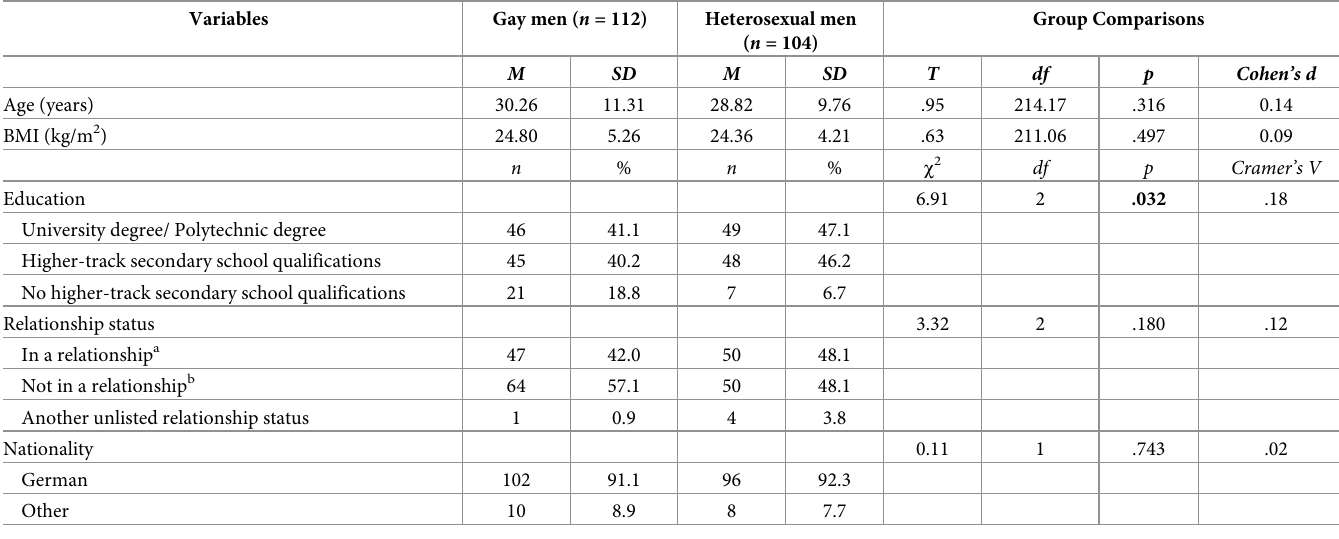
Table 1. Group comparisons regarding demographic